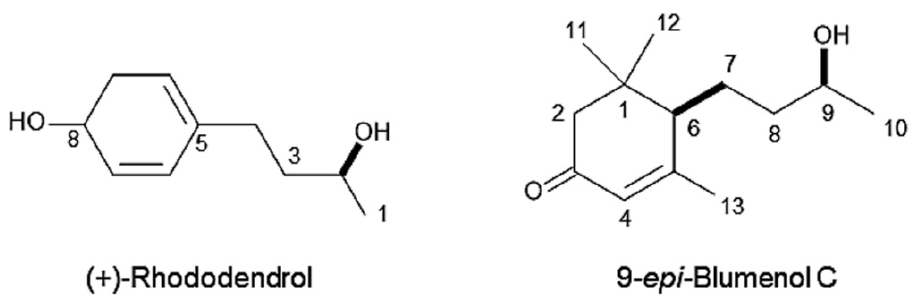
Figure 5. Chemical structures of (+)-rhododendrol and 9- epi -blumenol C.